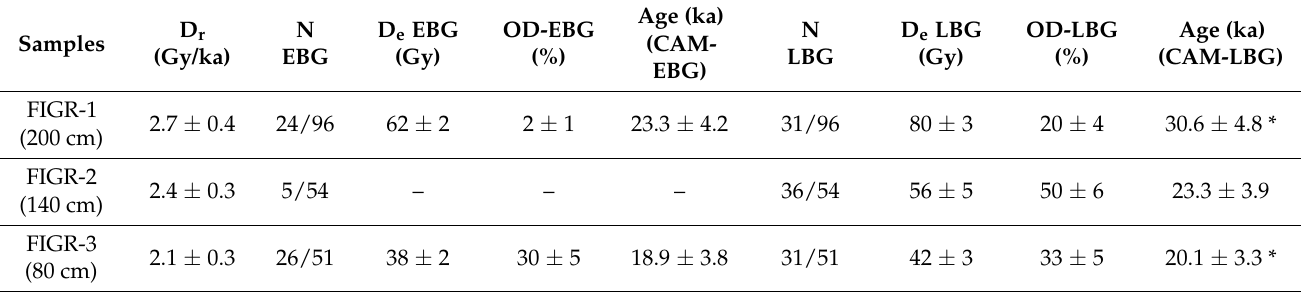
Table 3. Dose rate ( D r ) (Grays/ka), equivalent dose ( D e ) (Grays) and ages of the samples from the Cies Islands (FIGR: Figueiras 1, 2 and 3) (42 ◦ 13 (cid:48) 45 (cid:48)(cid:48) N, 8 ◦ 54 (cid:48) 15 (cid:48)(cid:48) W; WGS84), from EBG and LBG integration methods. Sampling distance (cm) from top to the base. (N) Number of aliquots accepted/analysed; ( OD ) Overdispersion percentage. (*) CAM-LBG ages (ka = kiloannum